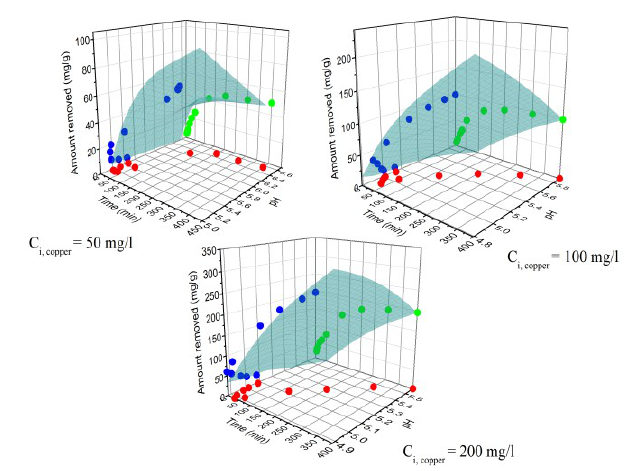
Figure 2. 3D surface representation of the effect of contact time on the amount of copper removed by Brushite (DCPD) and on the pH of